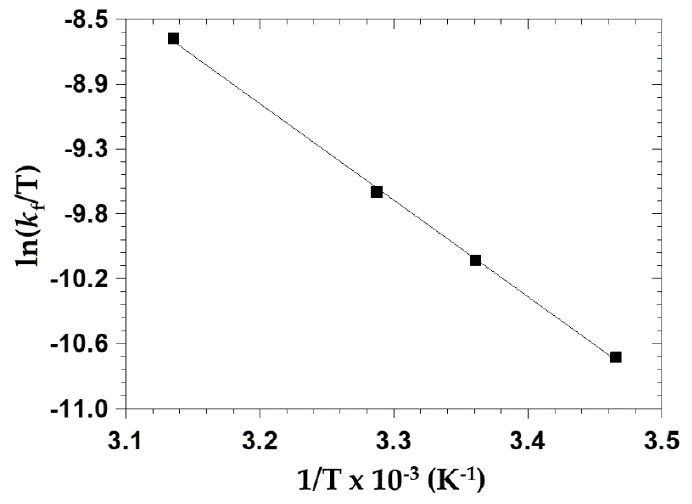
Figure 9. Eyring plot for the forward rate constant of the substitution of triphenylphosphine oxide from cis -[NbO(ca) 2 (H 2 O)OPPh 3 ] − by DMAP in acetonitrile.